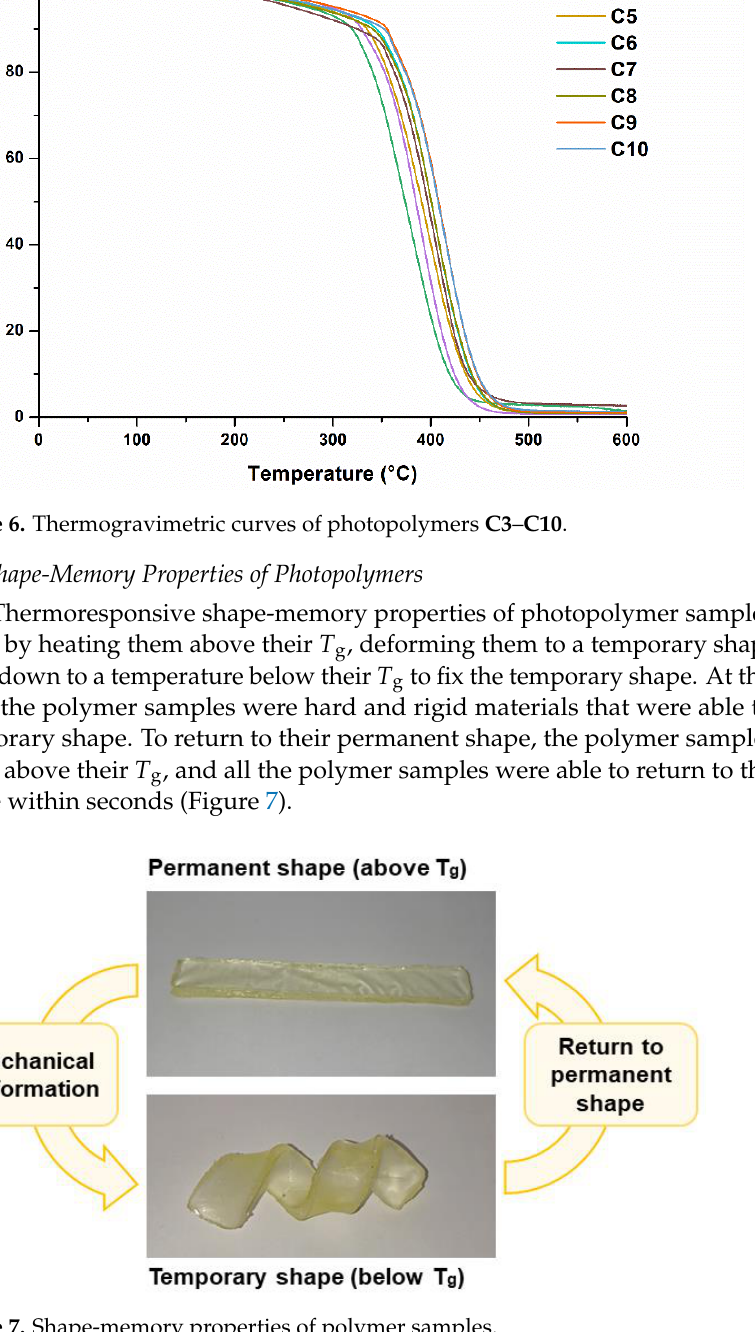
Figure 5. DMTA thermograms of photopolymers C3 – C10.